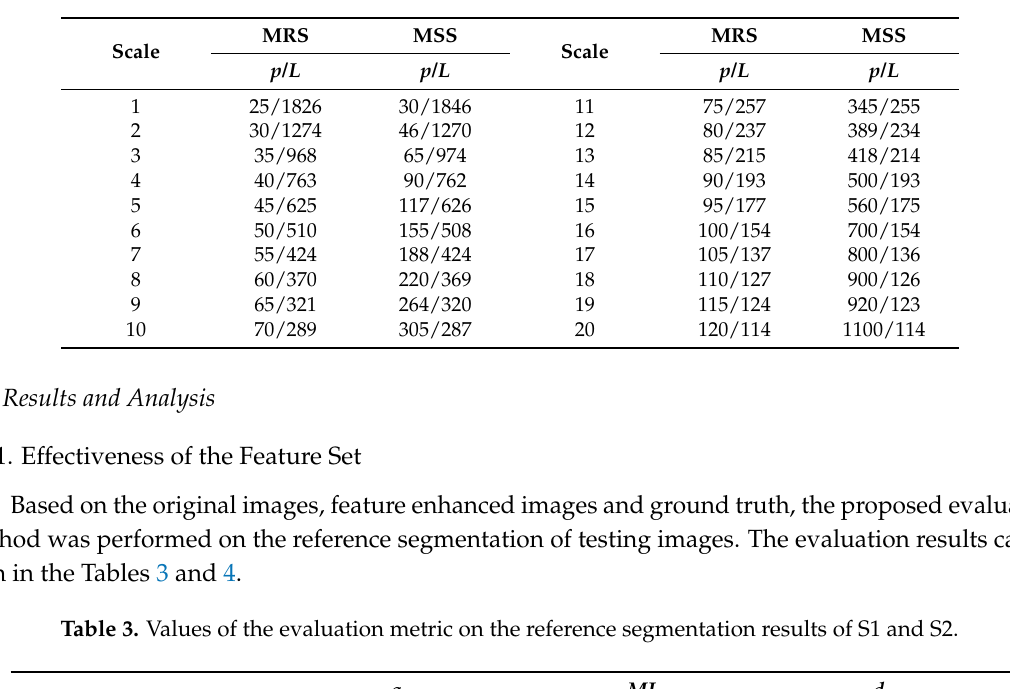
Table 2. Scale levels of MRS and MSS for testing image T3. p represents the scale parameter, and L represents the corresponding number of segments in the segmentation result.